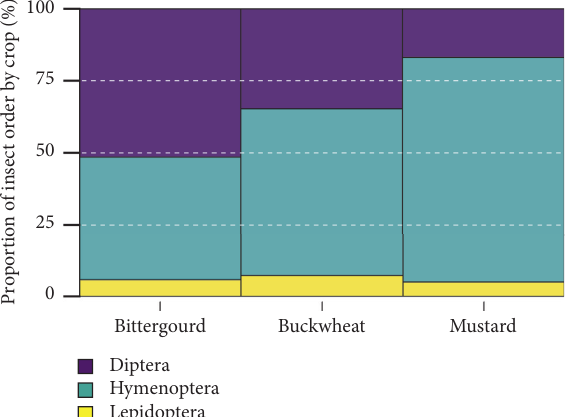
Figure 2: Proportion of the three insect orders (Diptera, Hymenoptera, Lepidoptera) sampled during open-access experiments within bittergourd, buckwheat, and mustard crops in Nepal. These orders include important pollinating groups as hoverflies, bees, and butterflies. Horizonal and white dashed lines were added every 25% to facilitate